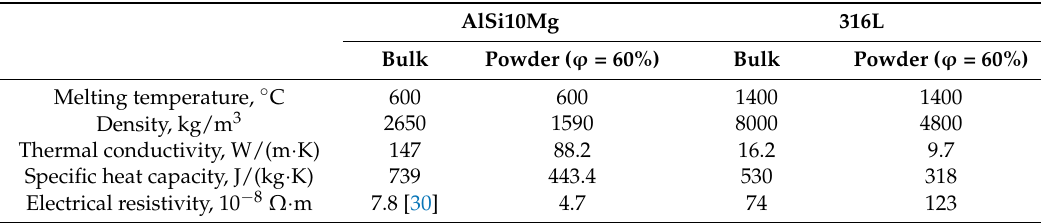
Table 3. Physical properties of the AlSi10Mg [13] and 316L [ 15 ] powders used for melt pool modeling.